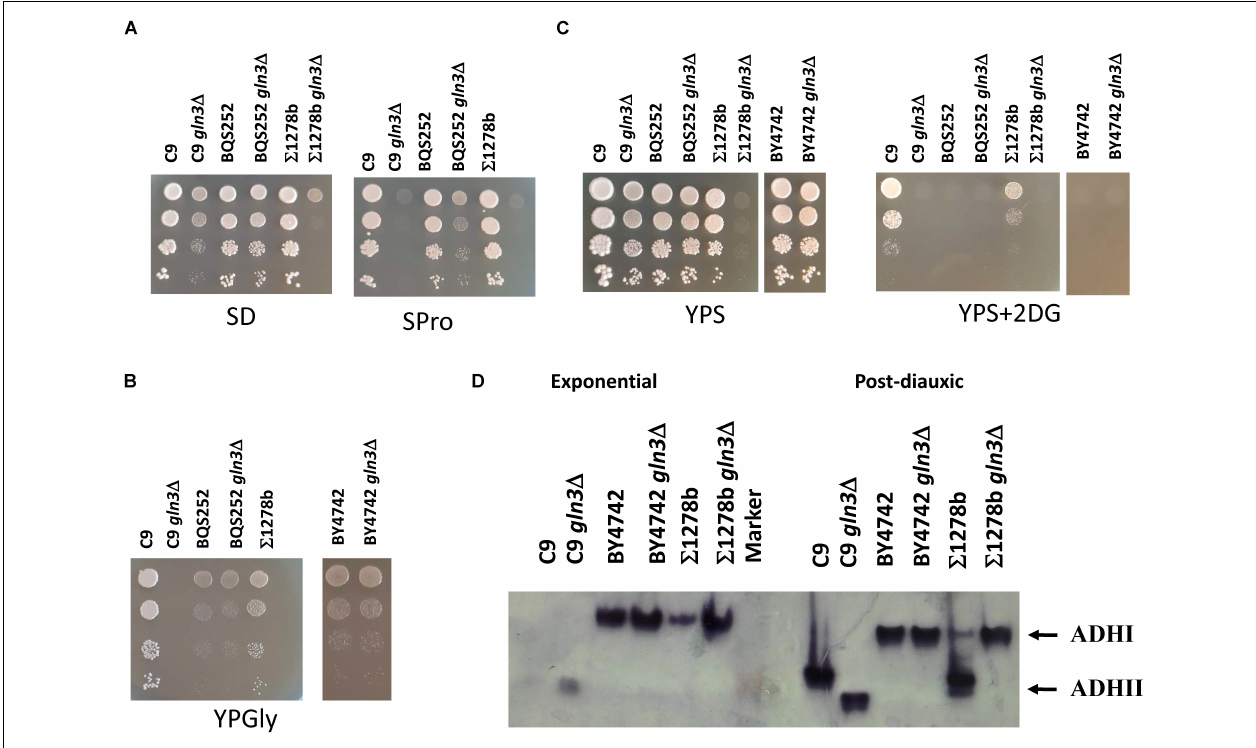
FIGURE 9 | Gln3 is required for respiration and glucose repression. (A) The spot analysis of mutants gln3 (cid:49) in three genetic backgrounds, BQS252, C9, and (cid:54) 1278b in medium with ammonium as the nitrogen source (SD) and proline as the nitrogen source (SPro). (B) The spot analysis of the same mutants in YPSucrose with or without 100 mg/ml of 2-deoxyglucose (2DG) to test glucose repression. (C) The same strains in YPGlycerol to check for respiration. (D) The zymogram of alcohol dehydrogenase activity. Samples of the gln3 (cid:49) mutants in BY4742, C9, and (cid:54) 1278b genetic backgrounds were taken under the exponential (repressing) and postdiauxic (derepressing) conditions, and run in a non-denaturing PAGE gel. Alcohol dehydrogenase isoforms I and II of strain (cid:54) 1278b are indicated by